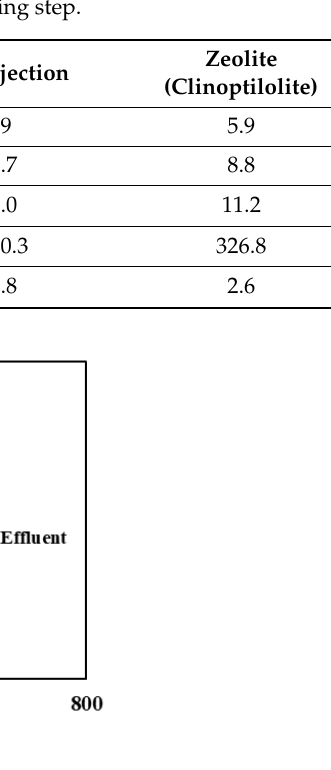
Figure 5. Change in the concentration of tar components in treated water upon tar wastewater treat- ment.